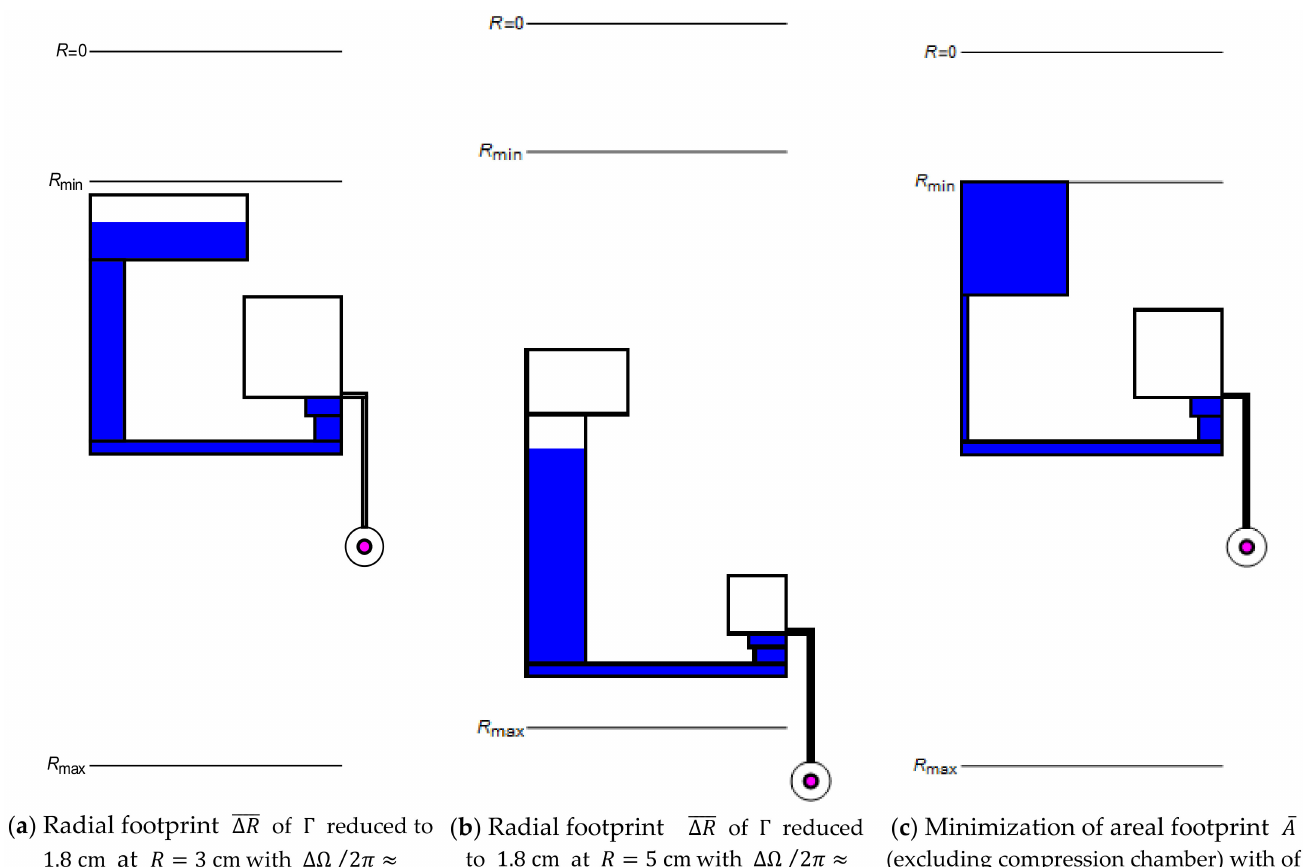
Figure 6. Geometrical optimization of Γ towards minimization of ∆Ω at a given Ω /2 π = 25 Hz toward minimum radial extension ∆ R (11) at the radial positions ( a ) R = 3 cm, ( b ) R = 5 cm, and ( c ) toward smallest spatial footprint A (13) at Ω /2 π ≈ 25